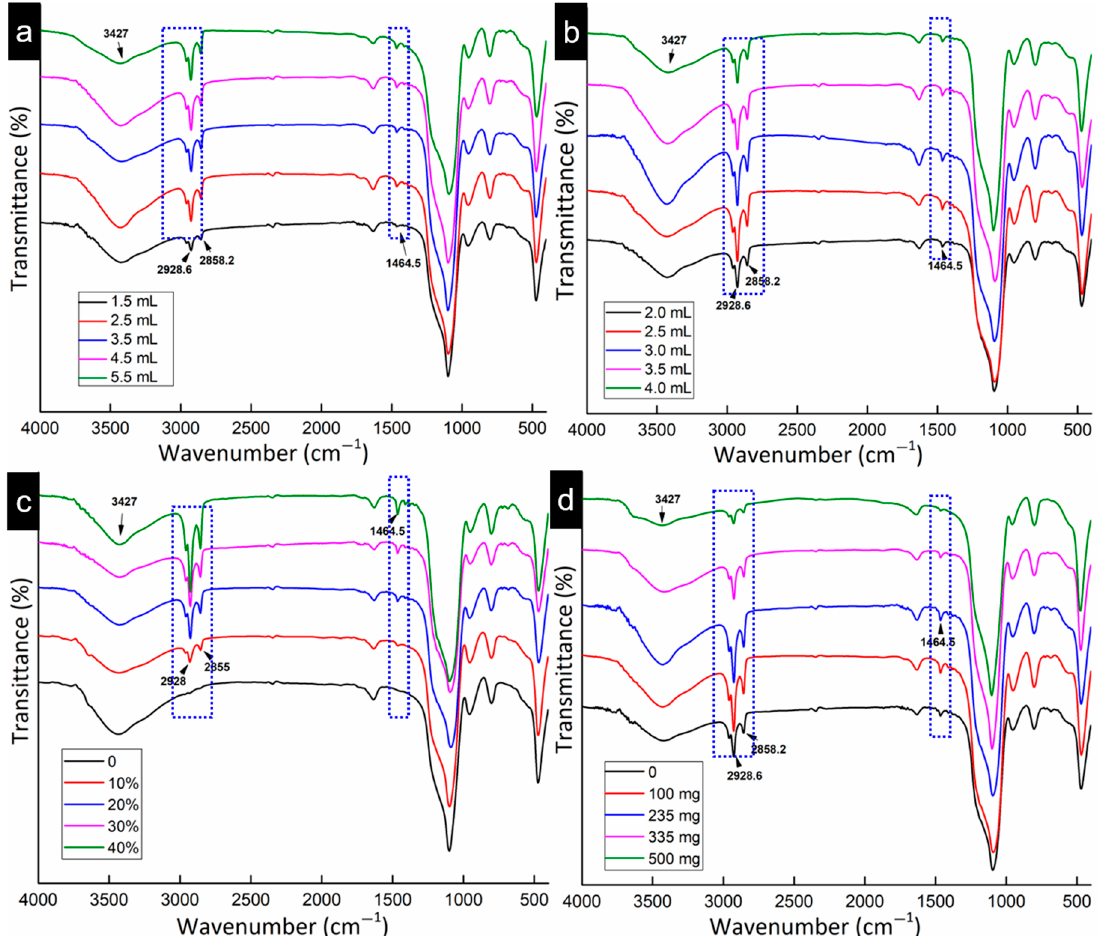
Figure 2. FTIR of organic hollow mesoporous silica formed by different influencing factors ( a ) The additional amount of silicon source deposited on the shell were 1.5 mL, 2.5 mL, 3.5 mL, 4.5 mL and 5.5 mL. ( b ) The ammonia hydroxide solution addition were 2.0 mL, 2.5 mL, 3 mL, 3.5 mL and 4 mL. ( c ) The ratio of OTMS to silicon sources deposited on the shell were